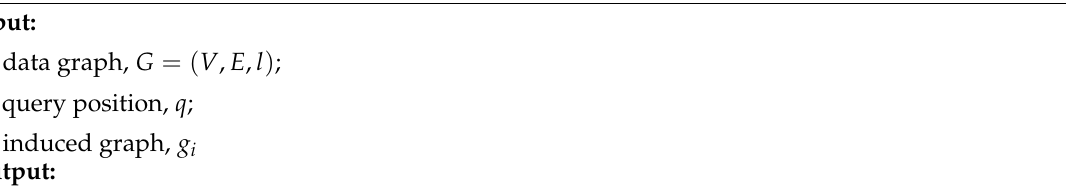
Algorithm 3 Query position-based subgraph